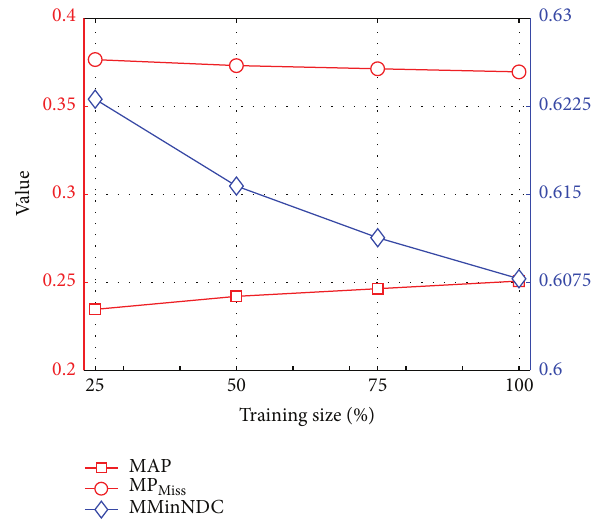
Figure 7: Event classification performance with respect to the training size.